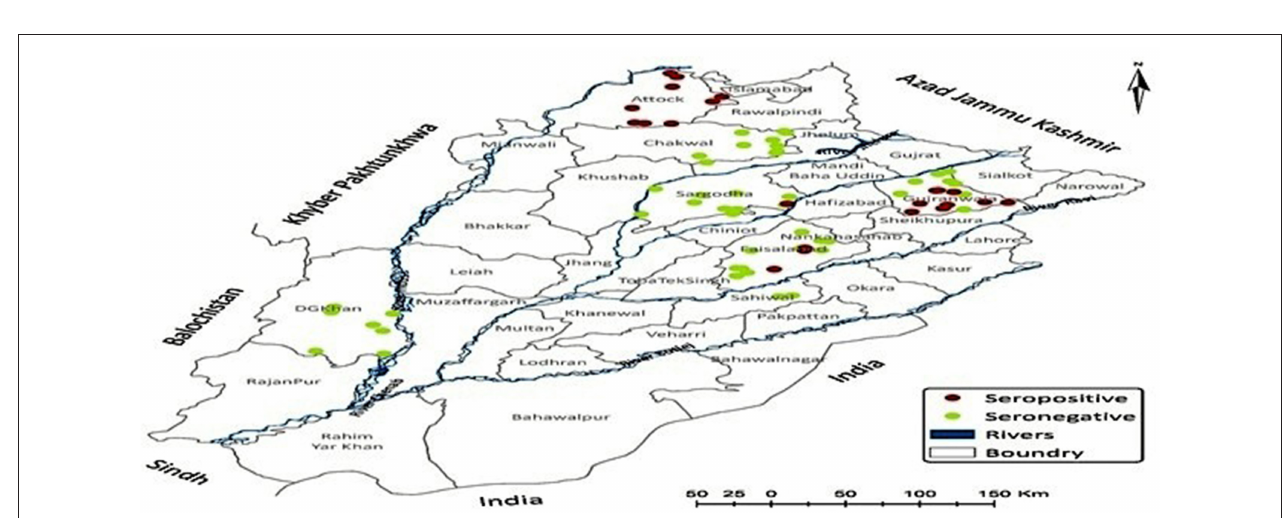
FIGURE 3 | Representation (squared cosine, cos2) of variables and individuals (sampling sites) along first two principal components.